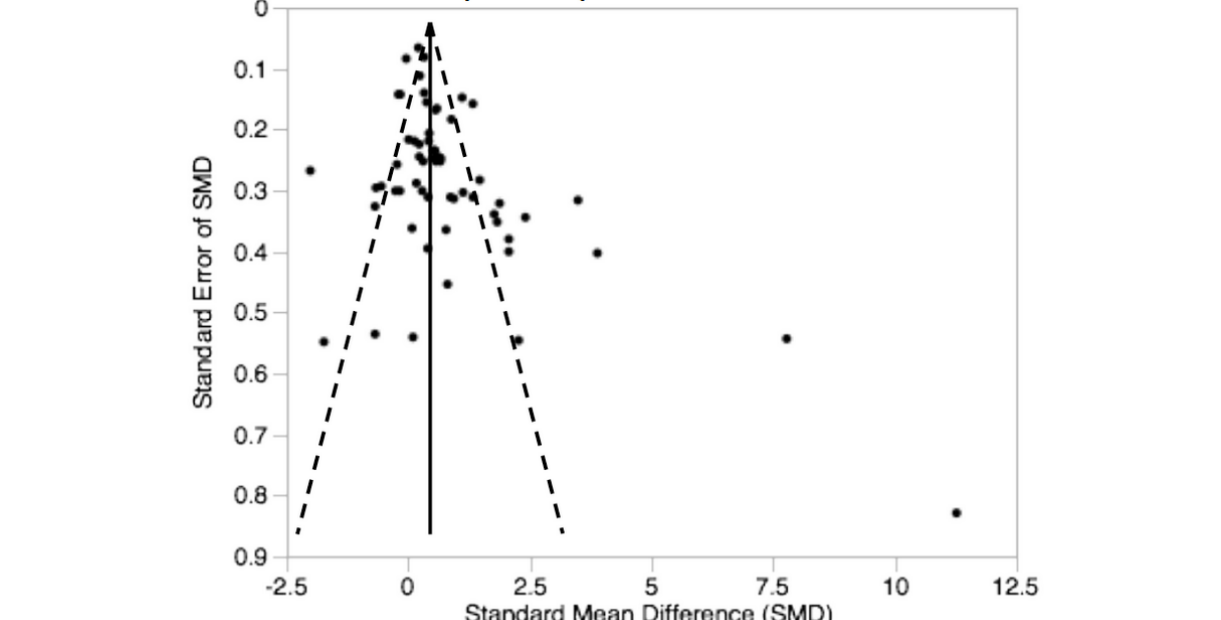
Figure 3. Funnel plot of blended learning versus traditional learning.